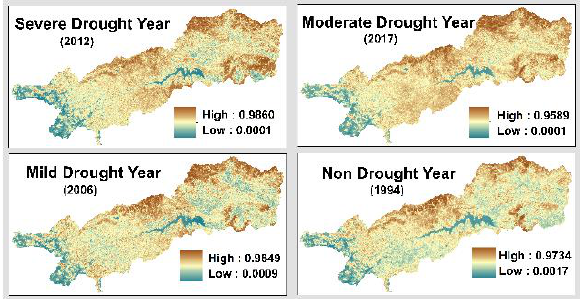
Figure 2. TVDI variation, indicative of the soil moisture conditions under different drought intensity